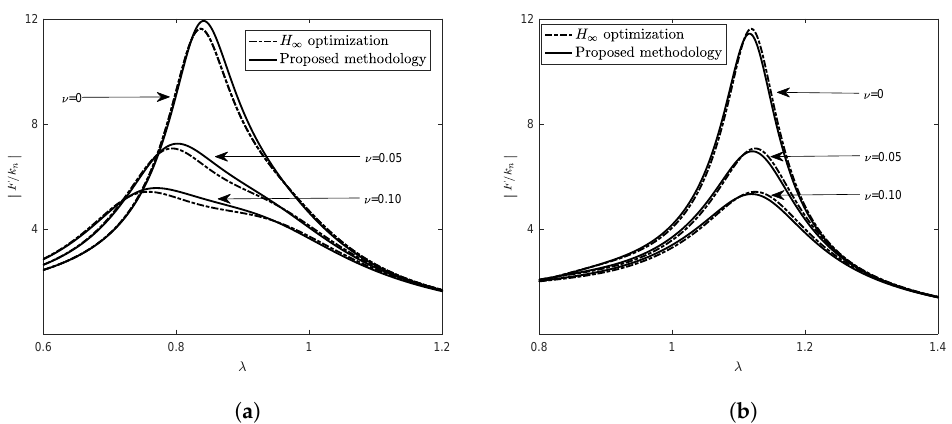
Figure 8. Comparison of the frequency responses of an uncertain primary system controlled by means of a TMDI corresponding to three levels of the inertance-to-mass ratio: ( a ) δ = − β ; ( b ) δ = + β . The parameters of TMDI were either analytically derived (marked by solid lines) or numerically solved (marked by dash-dotted lines). The mass ratio and the uncertainty remained unchanged, at µ = 0.05 and β = 20%, whereas three values of ν were used for the simulation: ν = 0, 0.05, and